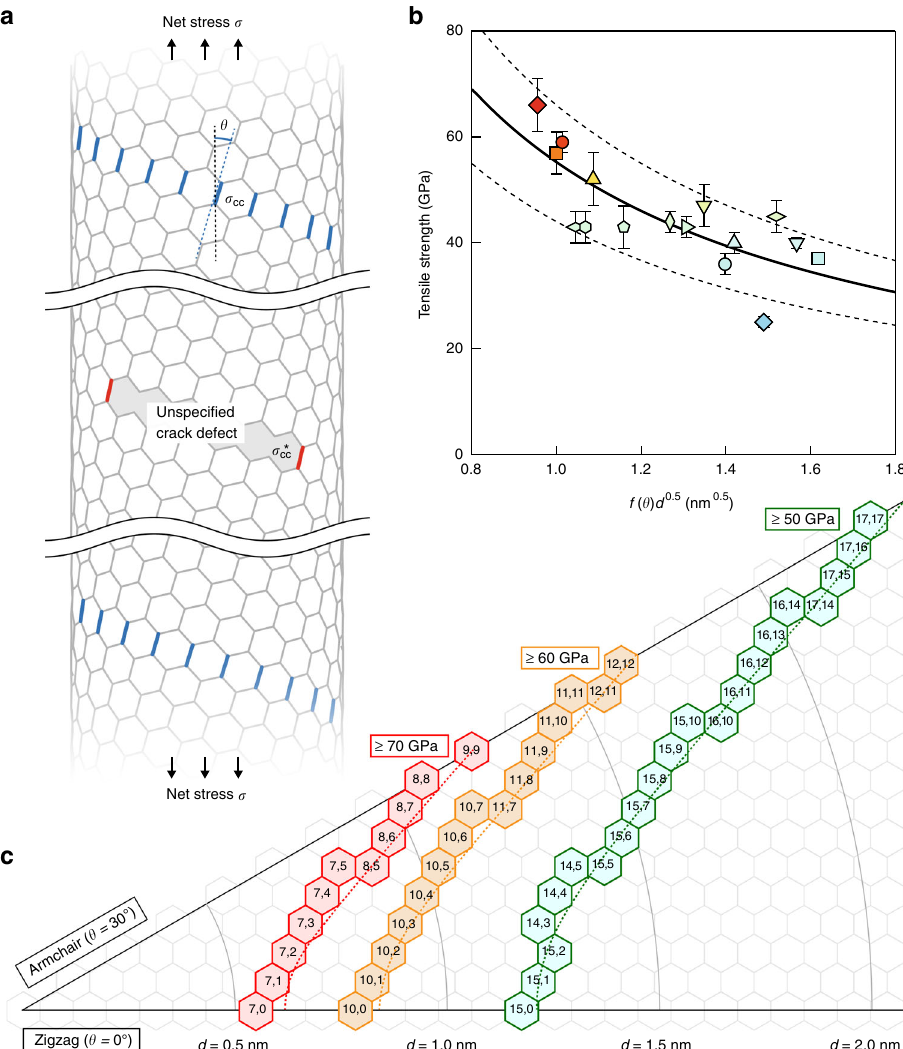
Fig. 4 Empirical modeling of nanotube tensile strength. a Net uniaxial stress, σ , effective stress applied on the C – C bonds, σ CC , at angle θ against the nanotube axis direction (blue), and concentrated stress, σ (cid:1) , on the C – C bonds (red) at the defect crack edges. b Tensile strength plotted as a function of ffiffiffi p CC f ð θ Þ d , where θ and d are the chiral angle and diameter, respectively. f ( θ ) is given by (1/2)[(1 − v ) + (1 + v ) cos 2 θ ] ( v = 0.16 is the Poisson ratio of graphite). ffiffiffi p d (cid:4) (cid:3) 1 , where C = 55 GPa nm 0.5 . The dotted curves indicate the ±20% range ( C = 44 and 66 GPa The solid curve is the best fi t to the data, which is C ½ f θ ð Þ nm 0.5 for the lower and upper curves, respectively). The error bars indicate the 95% con fi dence levels. c Empirical contour map of the tensile strengths. The red, yellow, and green regions show the chiral ( n , m ) structures, with predicted strengths of approximately 70, 60, and 50 GPa,